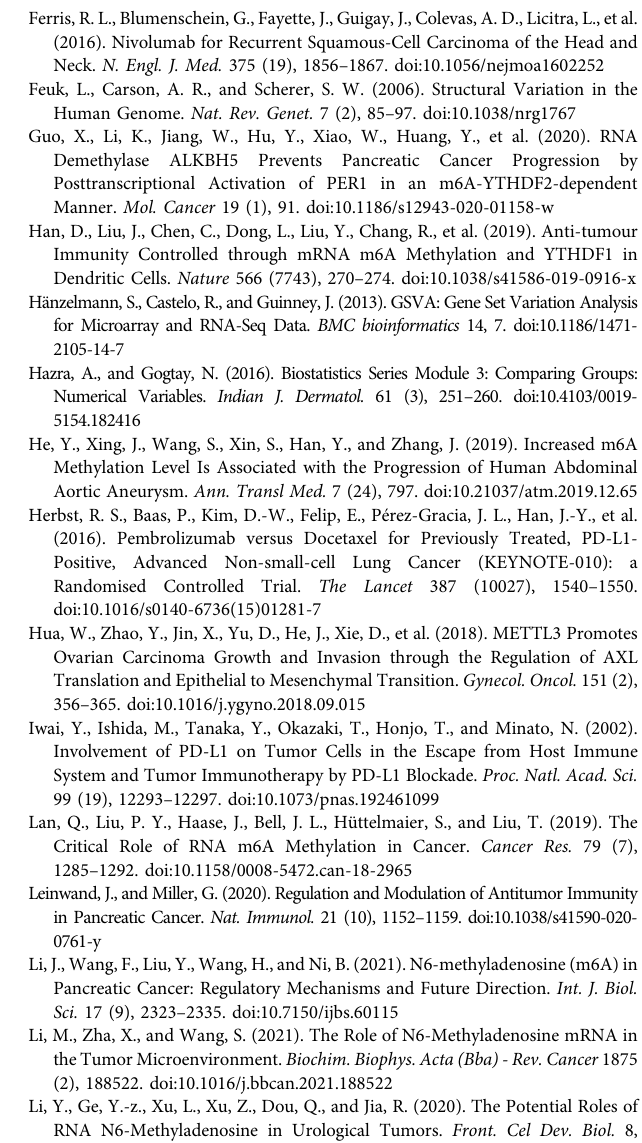
Supplementary Figure 2 | Molecular characteristics of gene clusters. (A) The heatmap depicted the expression levels of m6A regulators in distinct gene clusters; (B) GSVAenrichmentanalysisbetweengeneclusterAandgeneclusterB; (C) GSVA enrichment analysis between gene cluster A and gene cluster C; (D) GSVA enrichment analysis between gene cluster B and gene cluster C. Supplementary Figure 3 | Molecular characteristics of YTH-family genes. (A – C) The expression differences of YTHDF1-3 between tumor and normal tissues; (D – F) The expression differences ofYTHDF1-3 between the different tumor stage; (G) KM analysis of patients with distinct YTHDF1-3